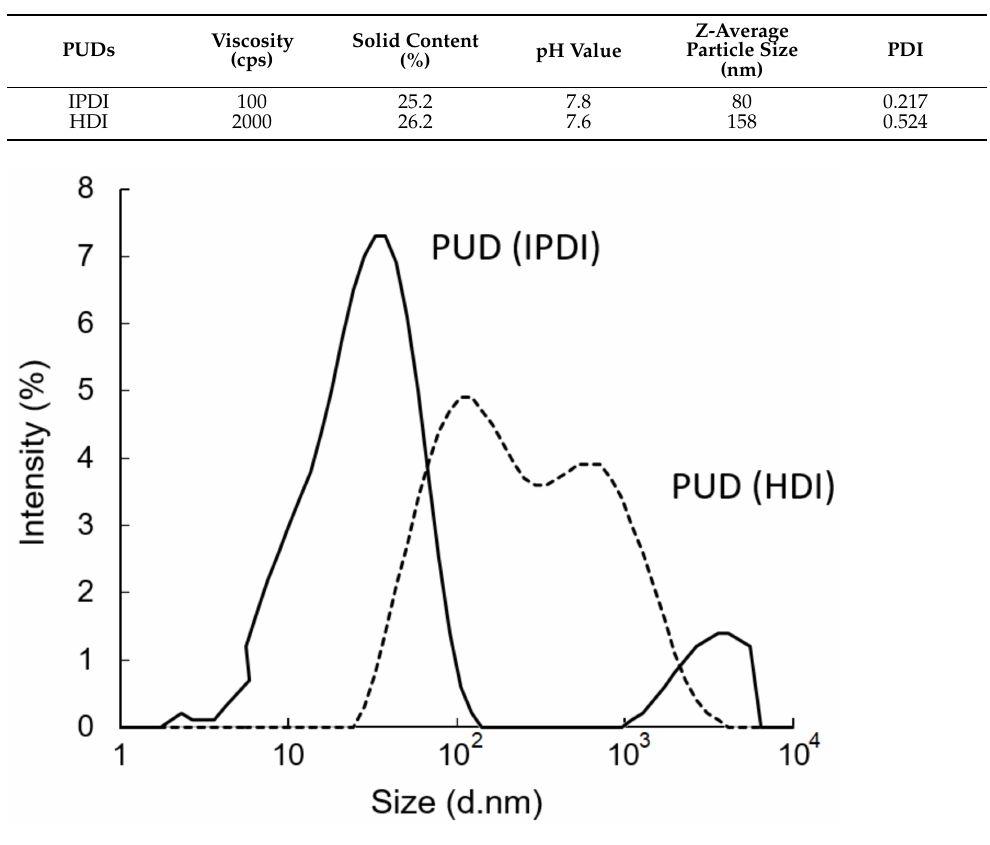
Figure 12. Appearances of prepolymers synthesized with ( A ) IPDI, ( B ) HDI, and of PUDs synthesized with ( C ) IPDI and ( D ) HDI. Table 2. Fundamental properties of PUDs synthesized with IPDI and HDI.